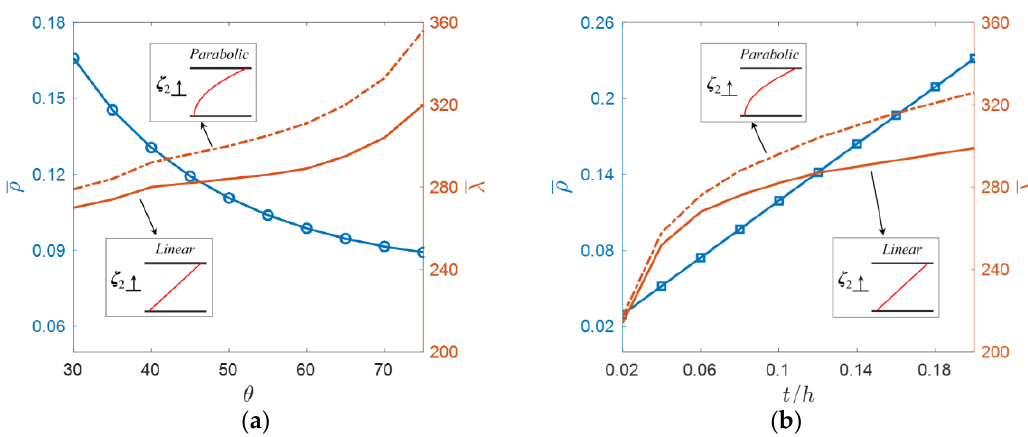
Figure 13. Effects of ( a ) inclined angle and ( b ) corrugation thickness on equivalent density and dimensionless critical dynamic pressure under a linear or parabolic temperature field.